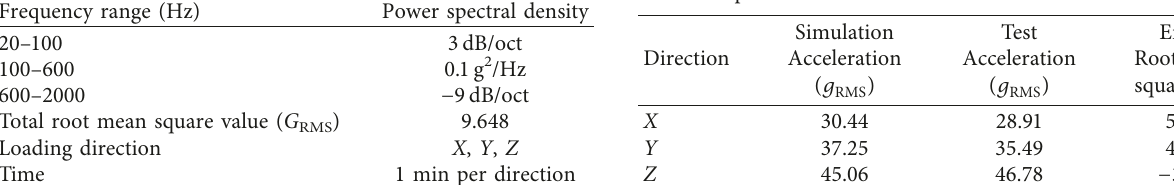
Figure 16: Frequency response curves at reference points in the Z direction. (a) Simulation curves. (b) Experimental curves. Table 8: Loading conditions for random vibration excitation. Table 9: Comparison of sinusoidal sine sweep resonance frequency and its response value.